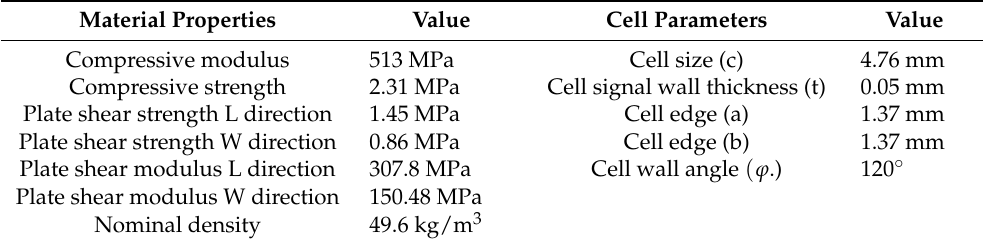
Table 1. Material attributes and cell parameters of AL honeycomb core